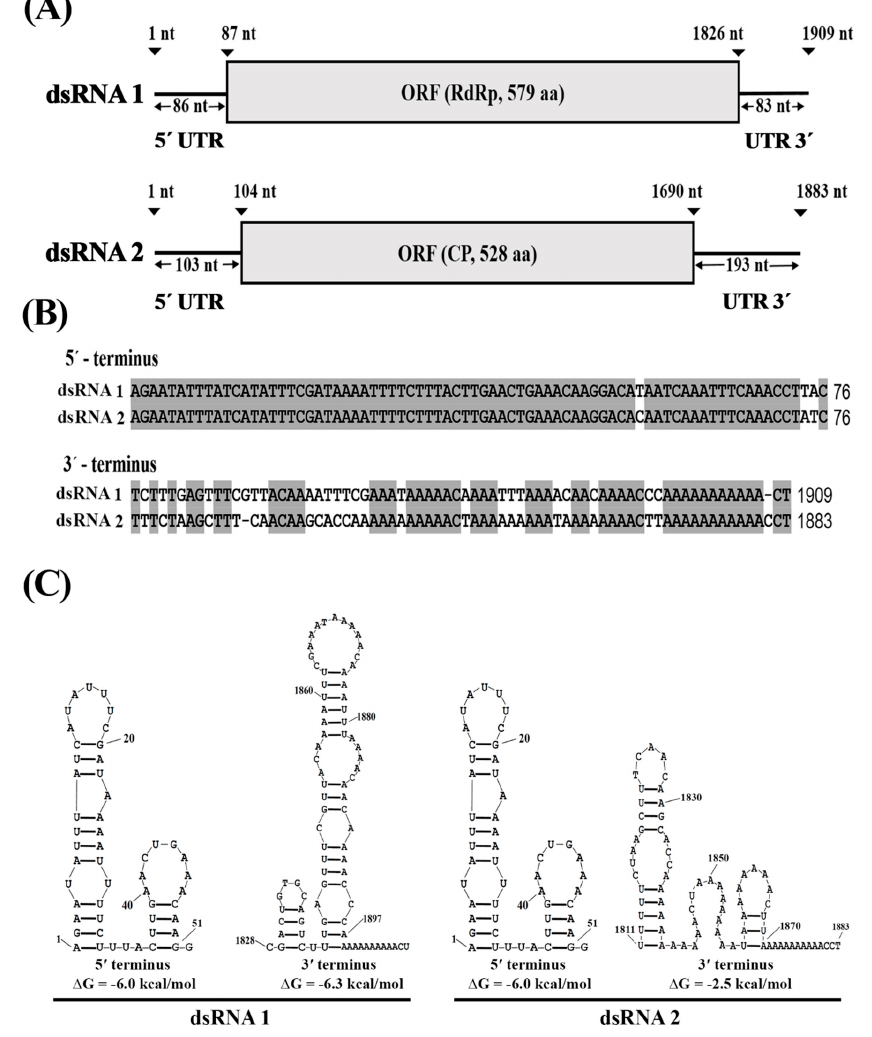
Figure 5. Genome structure of BcPV2. ( A ) A schematic diagram illustrating the segmented dsRNA genome. Each dsRNA has one open reading frame (ORF) flanked by two untranslated regions (UTR) at 3 ′ - and 5 ′ -termini; ( B ) Alignments of the partial nucleotide sequences of the 3 ′ - and 5 ′ -UTRs of dsRNA 1 and dsRNA 2. The identical nucleotides were highlighted in gray color. “-”, missing nucleotides; ( C ) Predicted secondary structures for the terminal regions of dsRNA 1 and dsRNA 2.